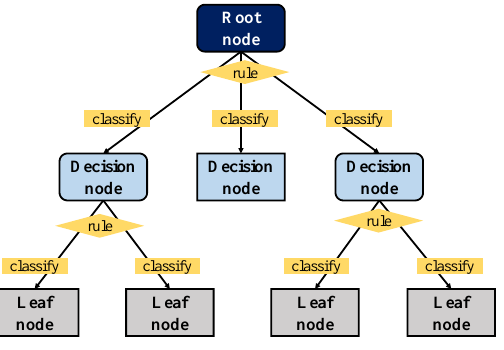
Figure 1. Decision tree.